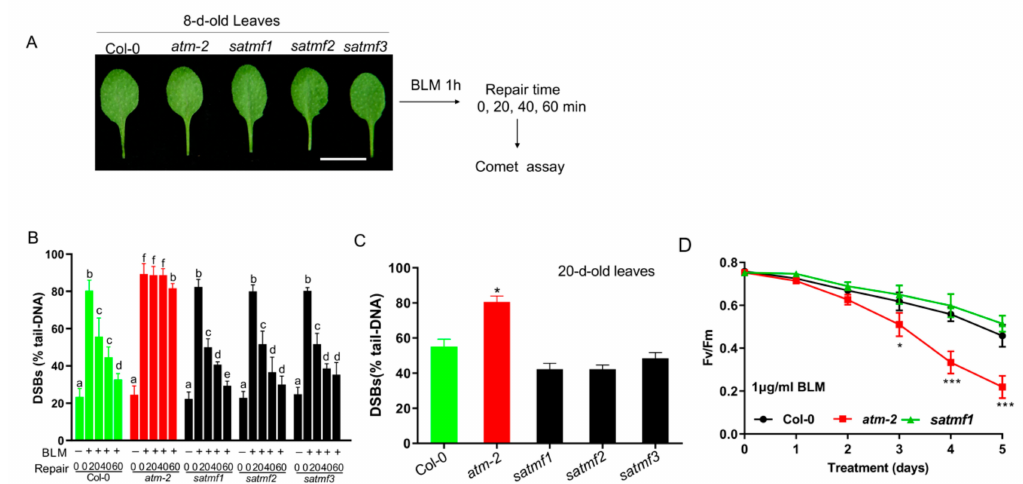
Figure 3. SATMF restores the DSB repair e ffi ciency in atm-2 background and delays DSBs-induced leaf senescence. ( A ) Experimental schematic of evaluation of DNA repair ability in satmf1~3 by comet assay. The 8-d-old third and fourth leaves of Col-0, atm-2 and satmf1~3 upon treatment with 10 µ g / mL BLM for 1 h were allowed to repair for 0, 20, 40, or 60 min, respectively, and used for comet assay. ( B ) Comet assay of the repair kinetics of the DSBs caused by BLM in the leaves in ( A ). Mean percentage of DNA in the tail at various recovery times after treatment was examined by comet assay. Three biological replicates were performed (mean ± S.D.). Di ff erent letters represent significant di ff erences (two-way ANOVA and post-hoc Tukey test, p < 0.05). ( C ) Comet assay of DSBs levels in the third and fourth leaves of 20-d-old Col-0, atm-2 and satmf1~3 plants, evaluated as the mean percentage of DNA in the comet tail. Values shown represent the mean of three independent trials ± S.D. Student’s t -test, * p < 0.05 ( D ) Photochemical e ffi ciency of PSII (Fv / Fm) in the leaves of Col-0, atm-2 , satmf1 plants upon treatment with 1 µ g / mL BLM for up to 5 d. Values shown represent the mean of three independent trials ± S.D. Student’s t -test: * p < 0.05; *** p <